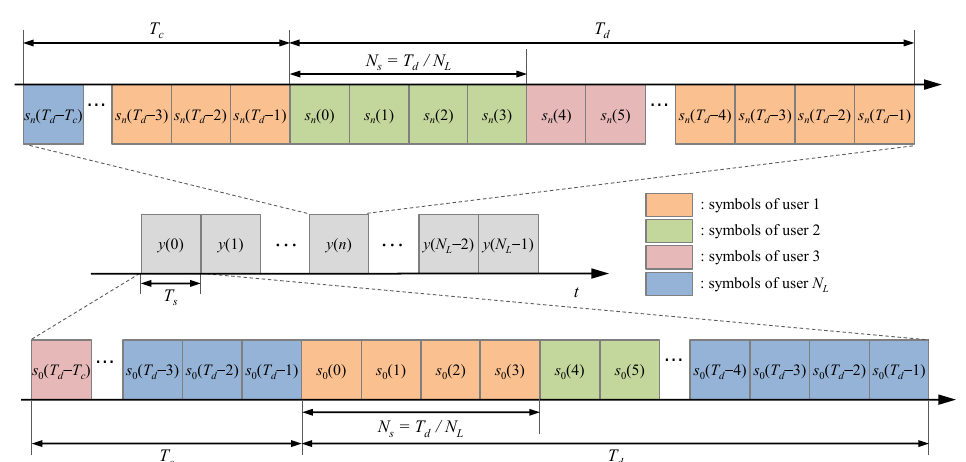
Figure 1. Contiguous frequency hopping orthogonal frequency division multiplexing (FH-OFDM) symbol structure for spectrum